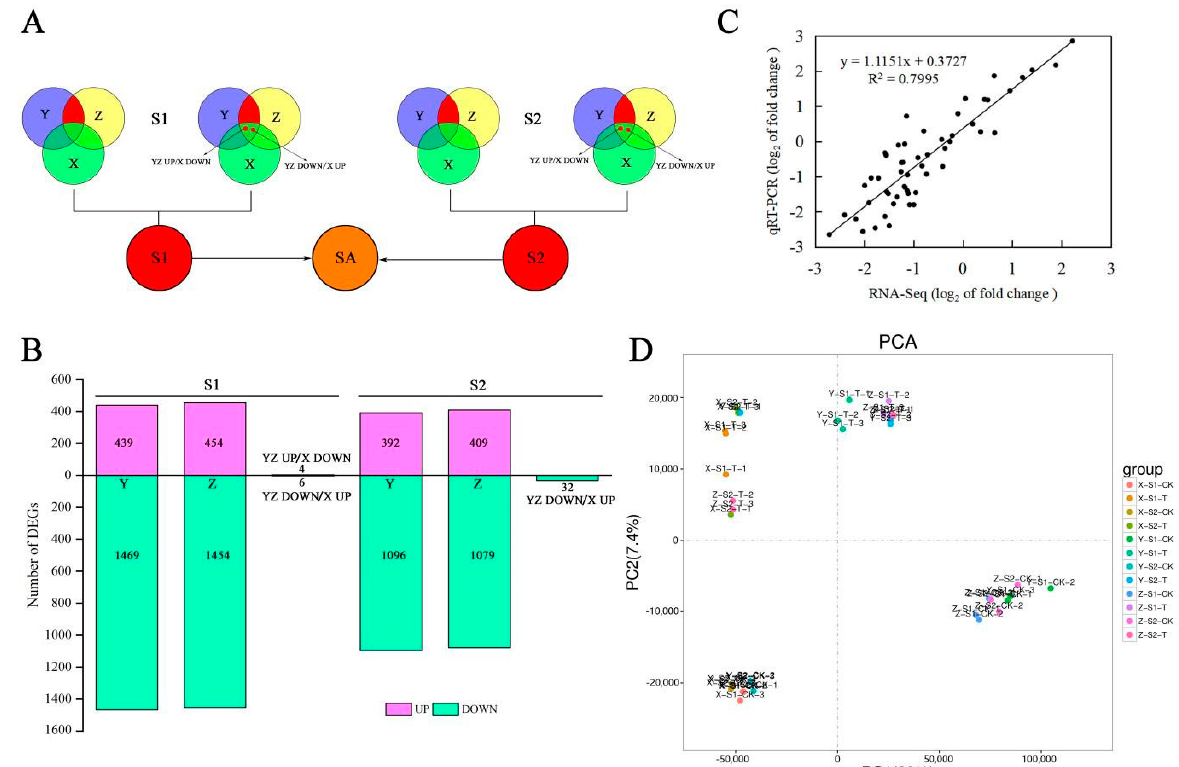
Figure 6. Statistics and verification of DEGs in transcriptome and principal component analysis (PCA) of samples. ( A ) Analysis strategy of transcriptome data. ( B ) Statistics of the number of DEGs in two growth stages. ( C ) Correlation analysis of transcriptome and qRT-PCR data. ( D ) PCA of transcriptome samples.